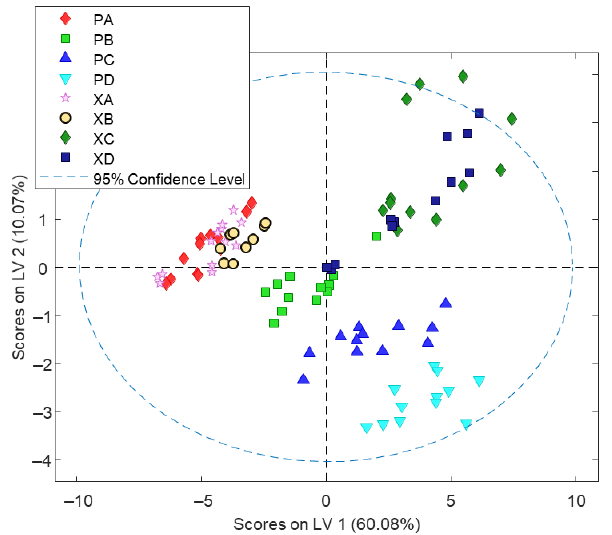
Figure 5. PLS-DA results for the multi-class classification of fermented products according to both quality and variety. Class assignation: A-type pinot noir (PA), A-type xarel·lo (XA), B-type pinot noir (PB), B-type xarel·lo (XB), C-type pinot noir (PC), C-type xarel·lo (XC), D-type pinot noir (PD), and D-type xarel·lo